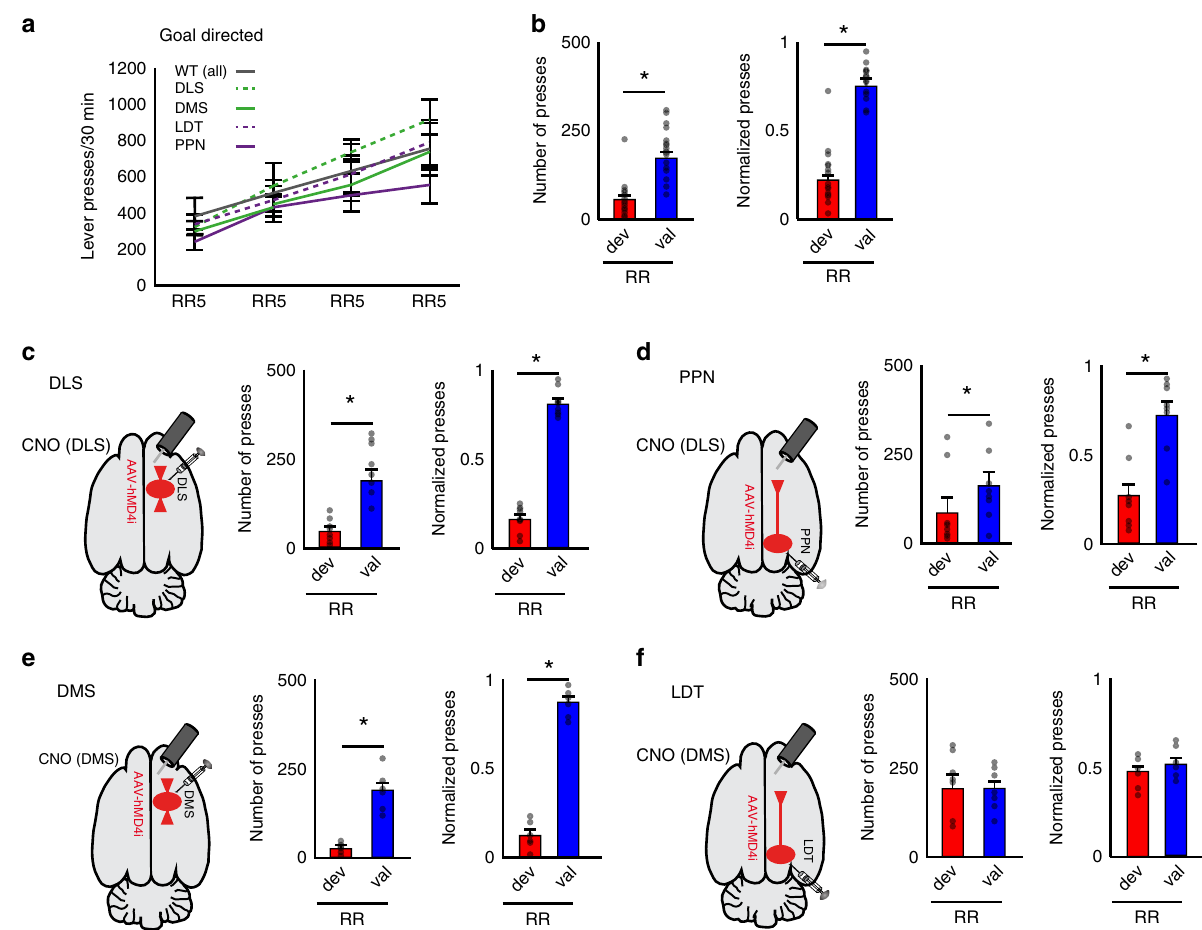
Fig. 6 Blocking of LDT cholinergic transmission in the striatum impairs goal-directed action selection. a Lever pressing during acquisition of goal- directed behavior shows no signi fi cant difference in the interaction between group and day of training (two-way ANOVA group [WT (all), DLS, DMS, LDT, PPN]×day: F group (4,180) = 2.60, P = 0.0375; F day (3,180) = 22.48, P = 0.00001; F interaction (12,180) = 0.46, P = 0.9343; n = 46 rats). b Number of presses and normalized lever presses during outcome devaluation testing across valued (val, blue) or devalued (dev, red) states in random ratio schedule (RR; goal- directed) in control animals. The number of presses was signi fi cantly different across sessions in all control groups (mixed ANOVA group × session[valued, devalued]; F group (3,16) = 0.65, P = 0.59; F session (1,16) = 37.035, P = 0.000016; F interaction (3,16) = 0.83766, P = 0.492824) as well as the normalized lever presses (mixed ANOVA group × session: F session (1,16) = 71.70, P = 0.00001, F interaction (3,16) = 1.43, P = 0.2706). Control groups were then pooled into one single group. c – f ChAT::Cre animals were injected in the DLS c , PPN d , DMS e or LDT f . During RR, signi fi cant differences in goal-directed devaluation were observed in the number of presses (mixed ANOVA group × session: F group (4,45) = 2.315, P = 0.07, F session (1,45) = 76.13, P = 0.00001; F = 6.31, P = 0.0004) and the normalized lever presses (mixed ANOVA group × session[valued, devalued], F = 138.39, P = interaction (4,45) session (1,45) 0.00001, and F interaction (4,45) = 7.44, P = 0.0001). Post hoc comparisons show differences in all groups except LDT (see text for values), suggesting that inhibition of LDT axons prevents animals from developing goal-directed behavior. Individual data points and mean ± SEM are shown. * P < 0.05. All experiments have been replicated at least three